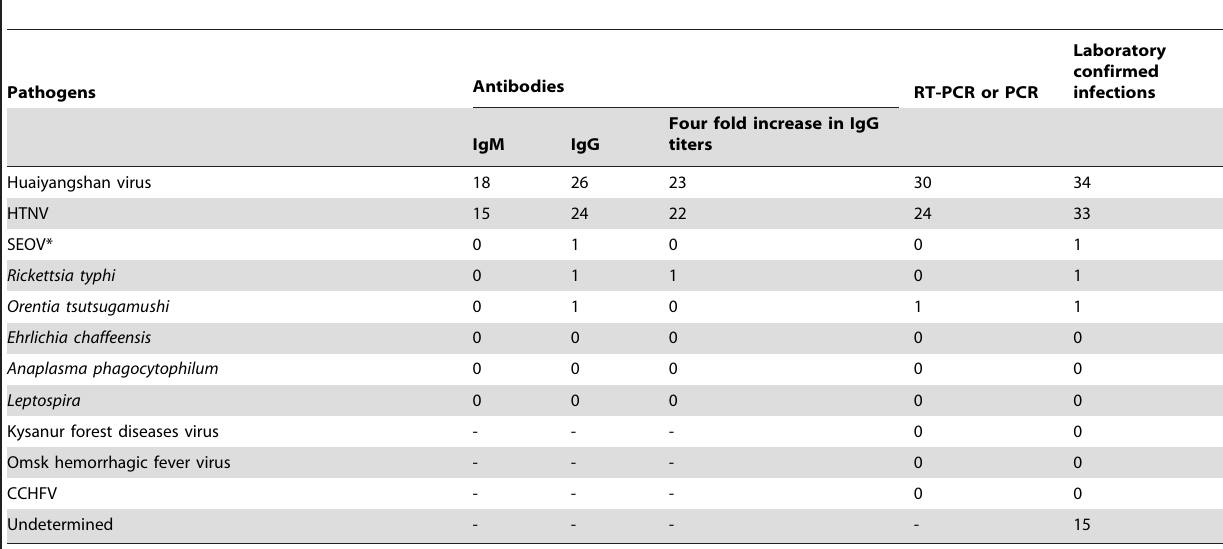
Table 2. Detection of pathogen-specific antibodies by indirect immunofluorescence and specific RNA/DNA by RT-PCR in serum